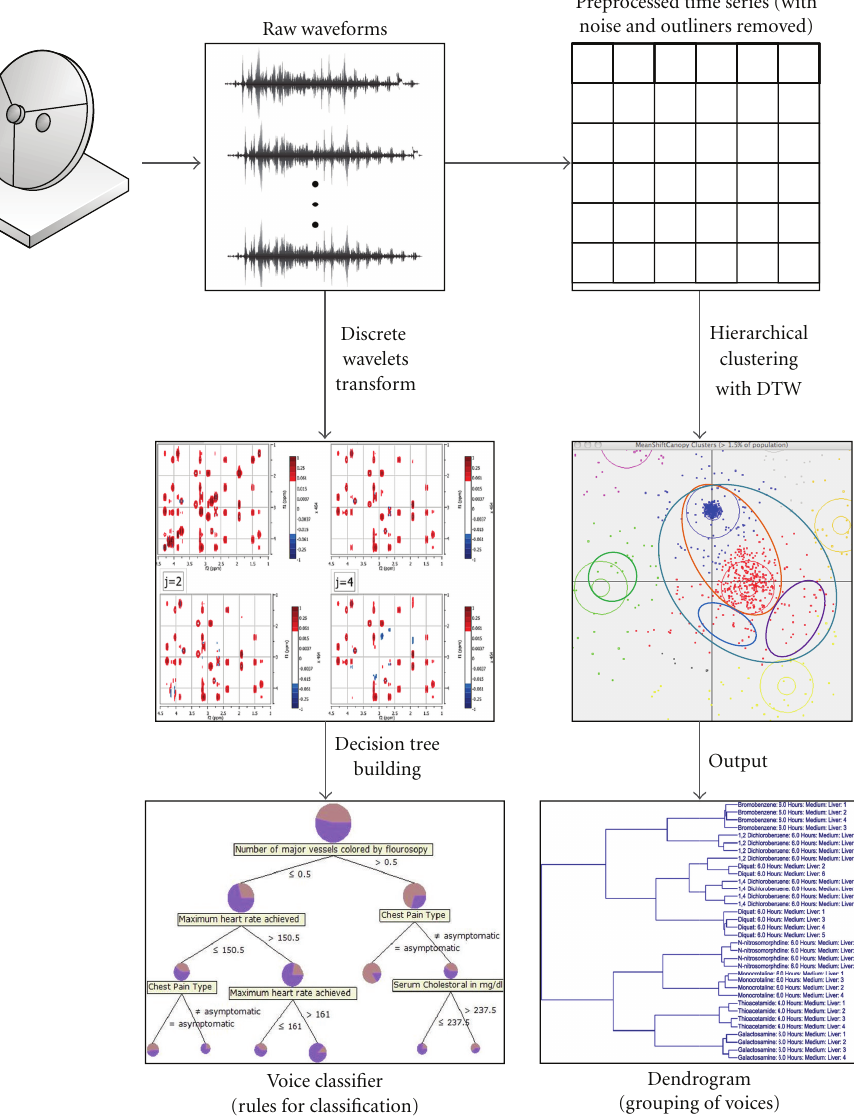
Figure 3: The proposed model of voice classification with hierarchical clustering.